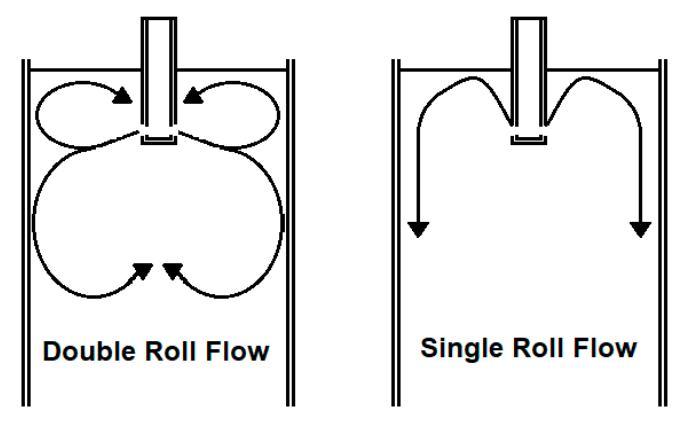
Figure 2. Flow patterns in a mold.